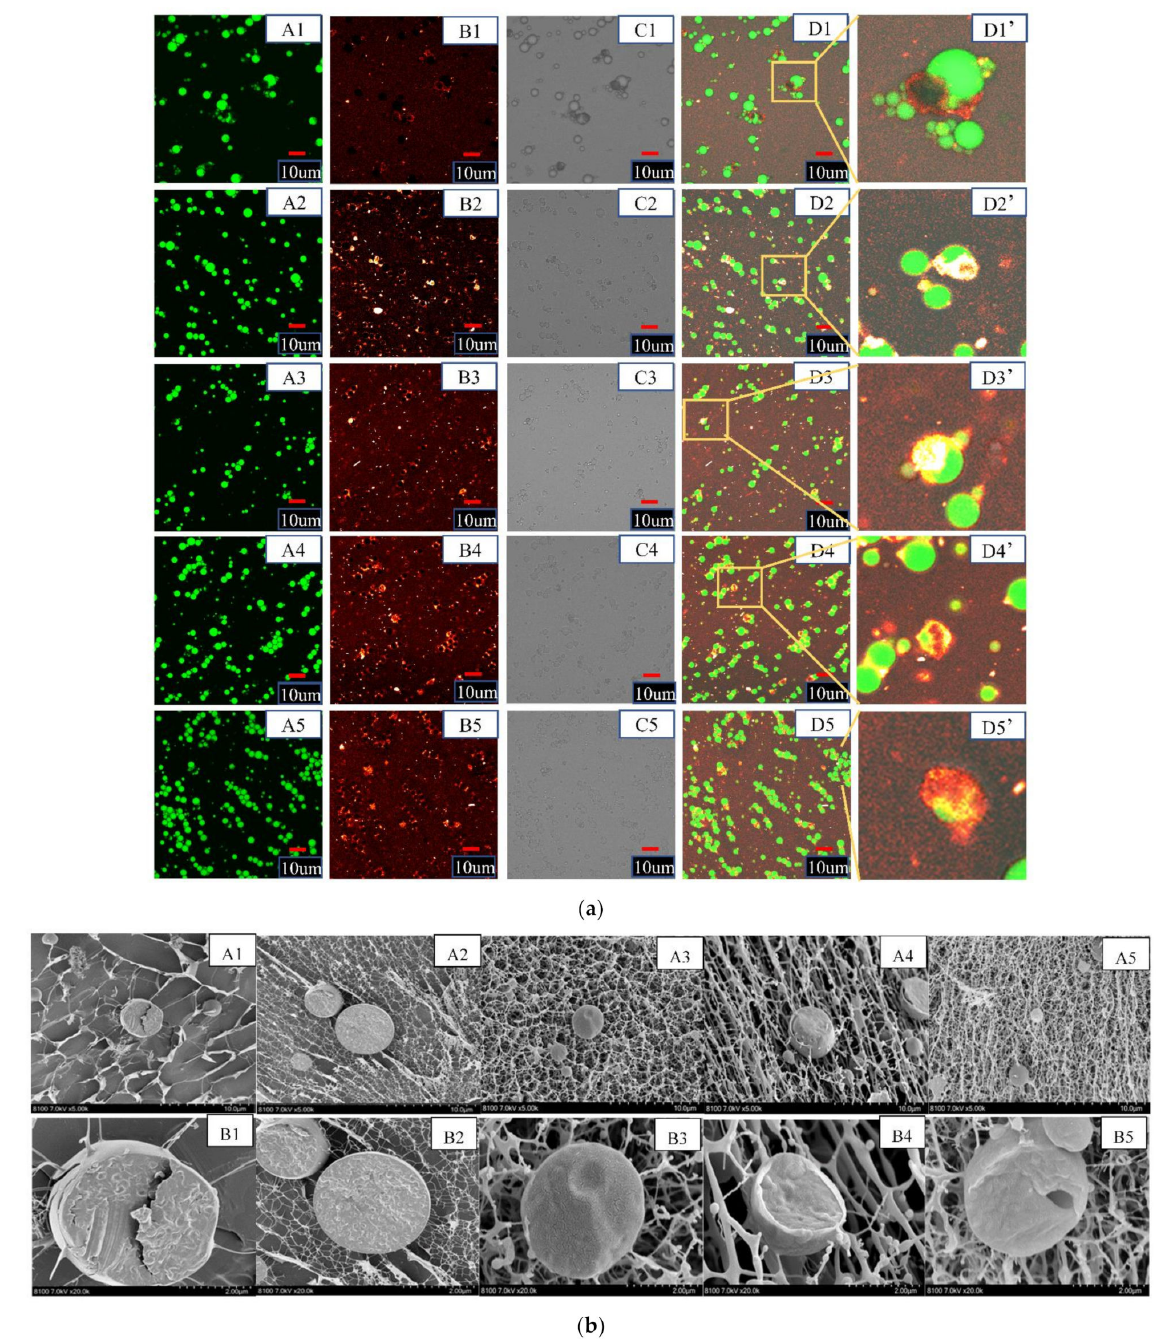
Figure 4. ( a ) Confocal laser scanning microscope images of the CaCO 3 S/O/W emulsions stabilized by NaCas and different concentrations of XG mixtures. (A, Oil phase was stained with Nile red, excitation at 488 nm; B, Protein phase was stained with Nile blue, excitation at 635 nm (ii); C, bright field view; D, combined image; D’, high magnified image). Scale bar: 10 um. (1–5: 0.1, 0.2, 0.3, 0.4 and 0.5 wt% XG). ( b ) Cyro-SEM images of the CaCO 3 S/O/W emulsions stabilized by NaCas and different concentrations of XG mixtures. (A, 5000 × ; B, 20,000 × ). (1–5: 0.1, 0.2, 0.3, 0.4 and 0.5 wt%